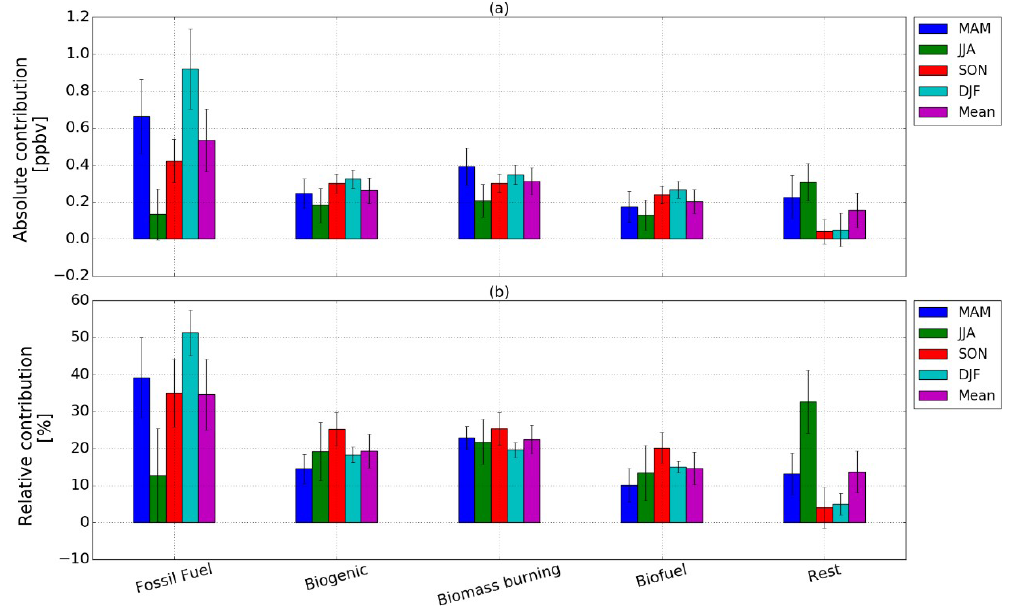
Figure 6. Absolute (a) and relative (b) contributions of fossil fuel, biogenic, biomass burning, and biofuel emission sources to the observed C 2 H 6 variability from 2015 to 2020 over Hefei, eastern China. The remaining contribution, calculated as the difference between the BASE simulation and the sum of anthropogenic and natural contributions, is also shown. All contributions are grouped by season. Vertical error bars represent 1 σ standard